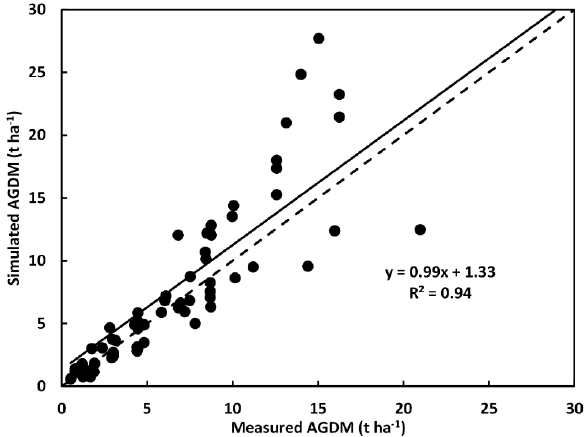
Figure 6. Measured and simulated above-ground dry matter (AGDM) for all the treatments not used in the calibration; different sowing dates, sowing rates, and soil water regimes.